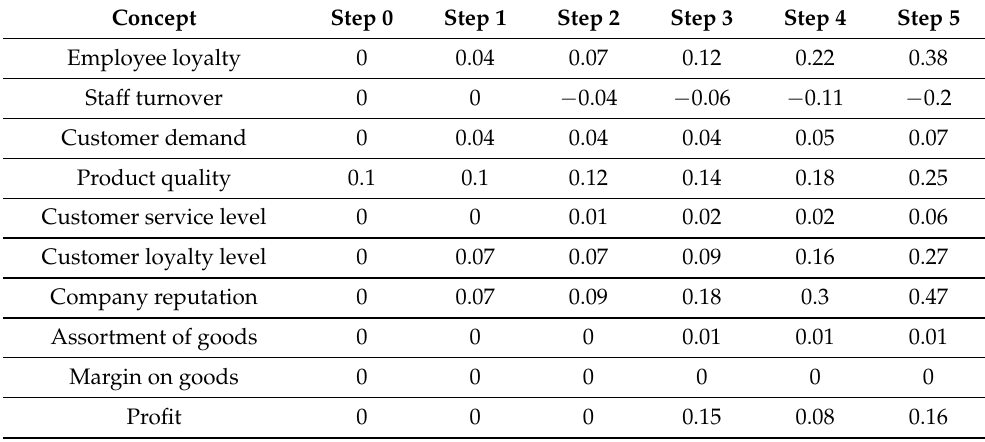
Table 4. Changes in the system concepts over five steps for the scenario of increasing “Product Quality”